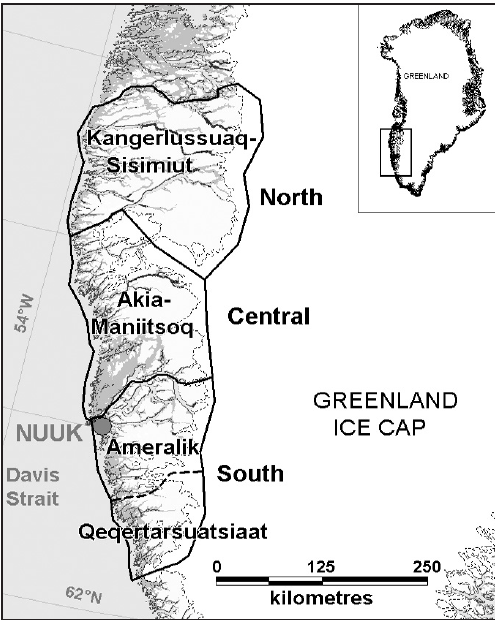
Fig. 1. Three West Greenland (North, Central, South) regions and the four caribou herds studied.